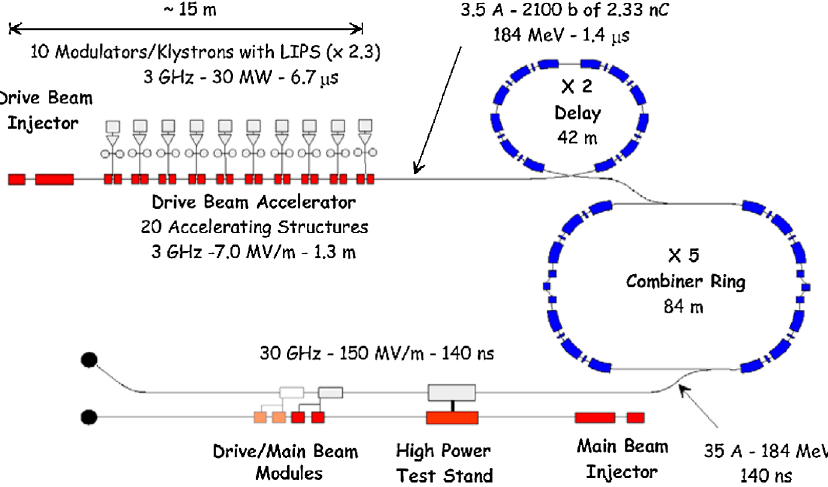
DL.FIG. 1. (Color) Conceptual layout of